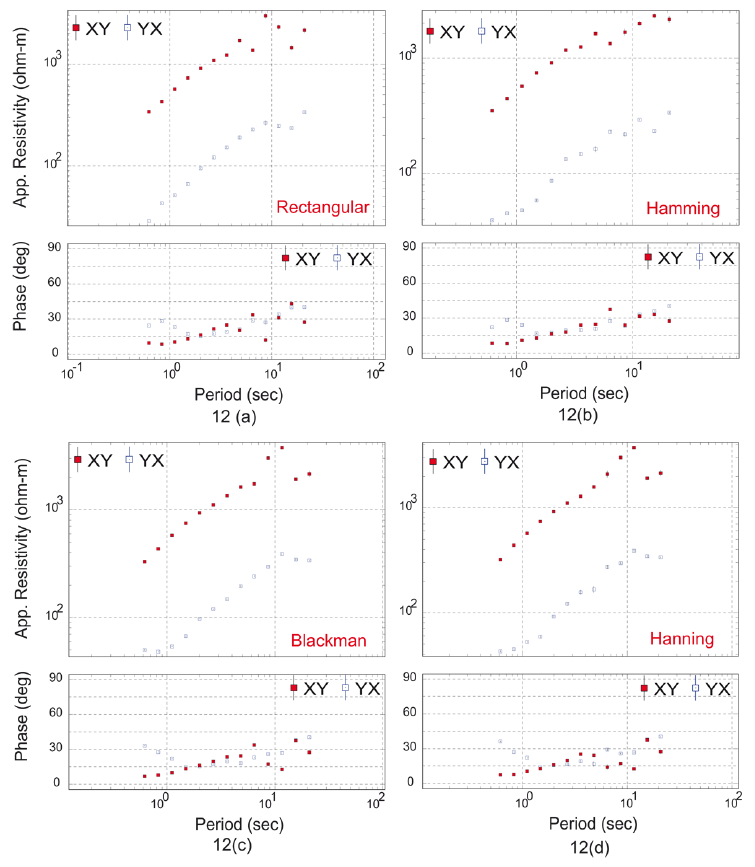
Figure 12. Result obtained after windowing with a fixed window length of 1024 from different window functions on 8 Hz data of site K11 from Koyna profile. (a) Apparent resistivity (upper panel) and phase (lower panel) curves obtained using Rectangular window. (b) Apparent resistivity (top panel) and phase (bottom panel) curves obtained applying Hamming window. (c) Apparent resistivity (top panel) and phase (bottom panel) curves obtained from Blackman window. (d) Apparent resistivity (upper panel) and phase (lower panel) curves obtained using Hanning window. Hamming window provides a better result than the others which is followed by the output of Blackman window. The red colored boxes represent XY components and the blue colored boxes represent YX components of apparent resistivity and